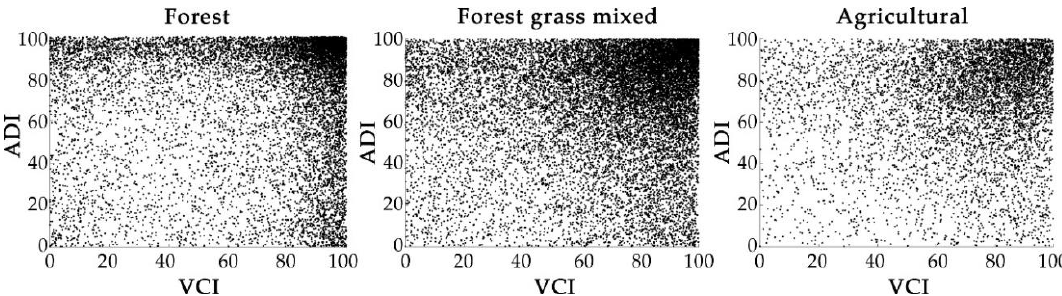
Figure 2. Scatter diagram of vegetation conditions index (VCI) and antecedent drought index (ADI) for forest, forest grass mixed and agricultural land types in 2016.